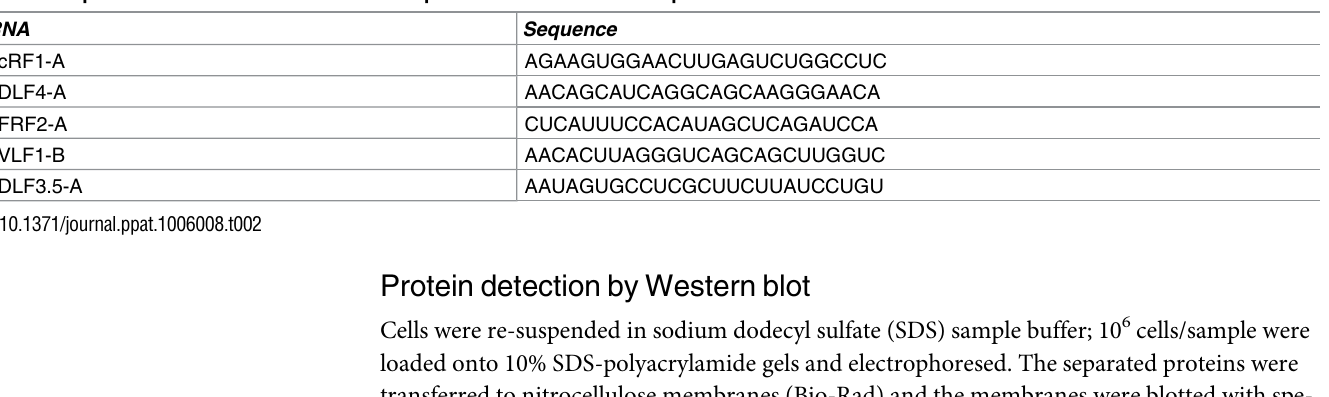
Table 2. Sequences of siRNAs used to silence expressionof individual components of